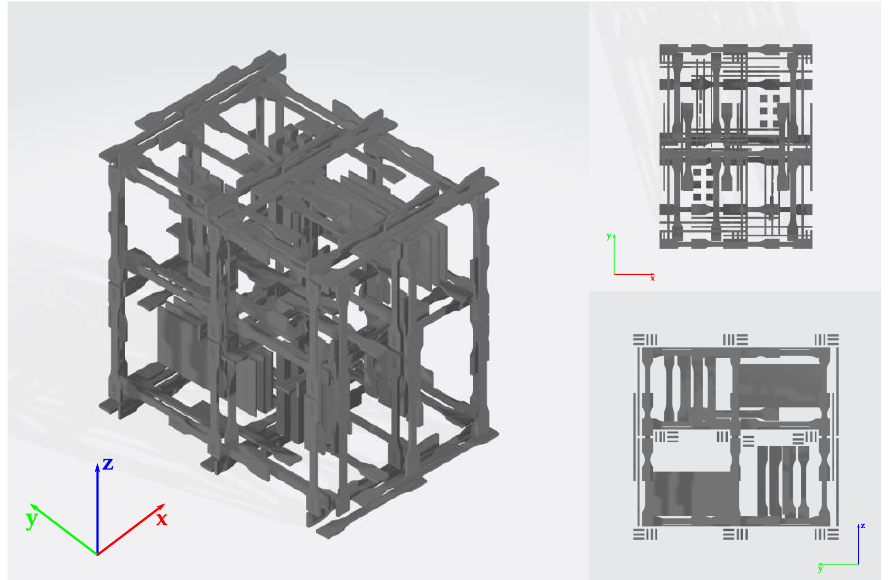
Figure 2. The distribution and orientation of the respective samples inside the print chamber.